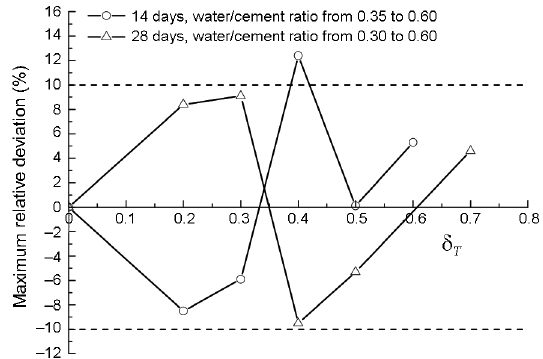
stressFigure 7. Influence of mix proportions of concrete on stress influence coefficient under tensile